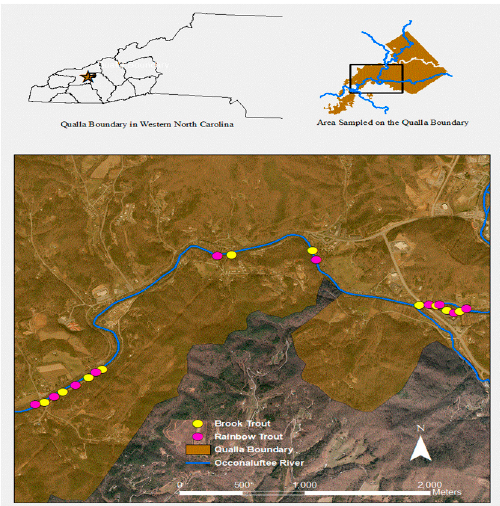
Figure 3. Site map showing deployment locations of carcasses on the Oconaluftee River on the Cherokee Qualla, western North Carolina.